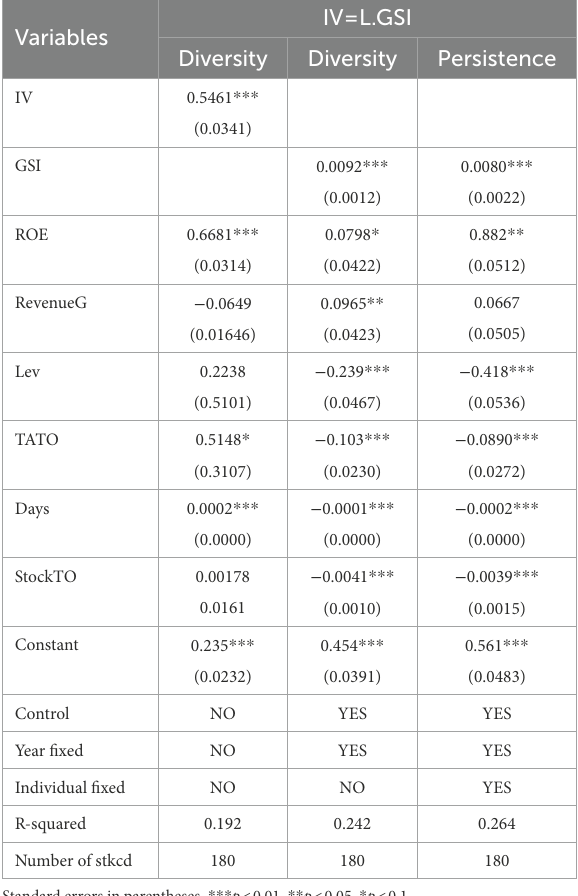
TABLE 5 Robustness tests of instrumental variable